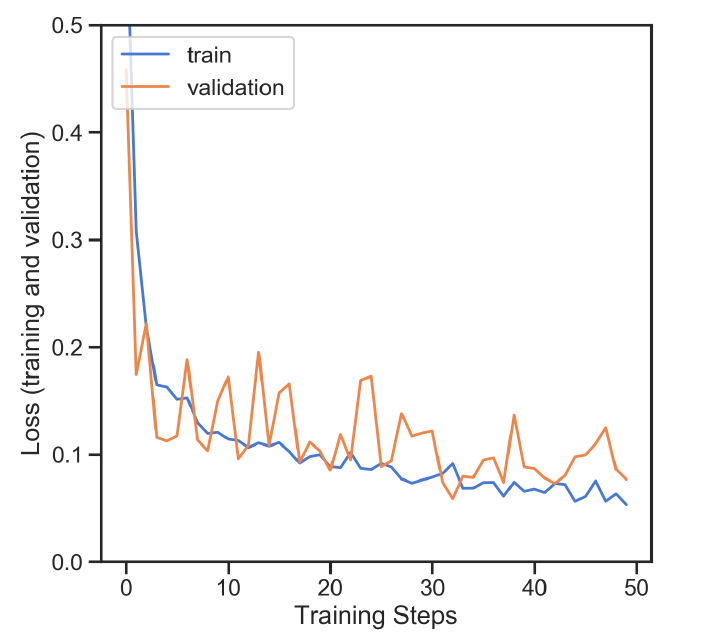
Figure 15. Loss function case 4 in Table